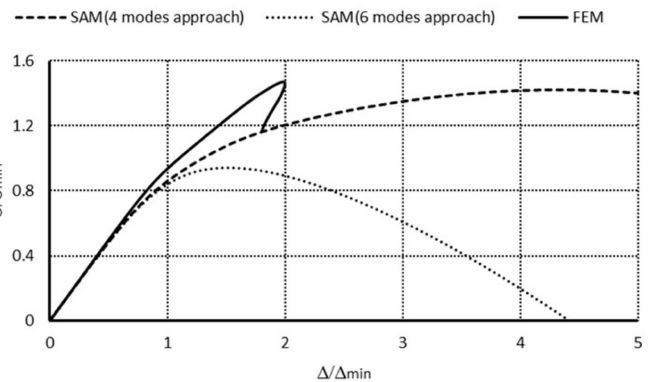
Figure 8. Comparison of dimensionless equilibrium paths for the channel of total length L = 210 mm.